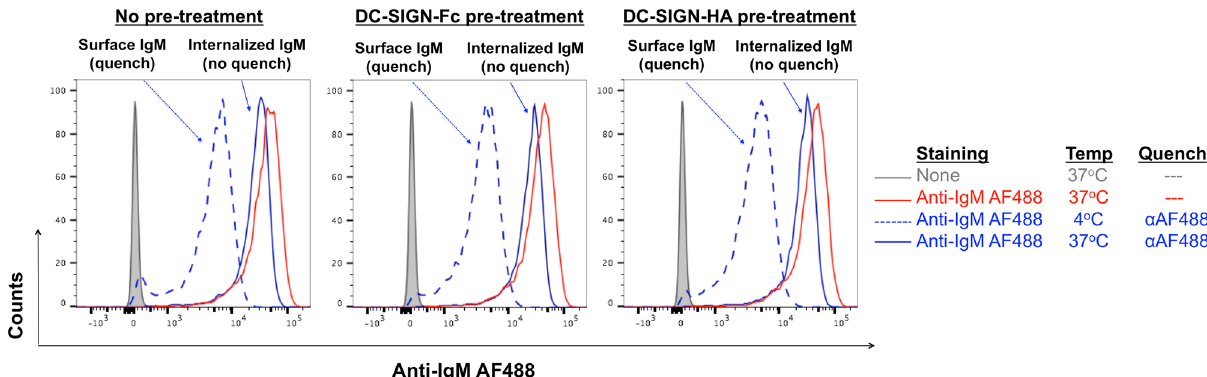
Figure 5. Effect of DC-SIGN pre-exposure on anti-IgM-induced endocytosis. ( a ) WSU-FSCCL cells incubated with AF488-conjugated anti-IgM (5 μg/ml) at 4 or 37 °C or were left untreated for 30 min. Then cells were incubated with anti-AF488 antibody (30 min at 4 °C to quench AF488 remaining on the surface), or left untreated. Graph on the left shows cells with no pre-treatment, whereas graphs in the middle and right show results for cells that were pre-treated for 30 min at 4 °C with DC-SIGN-Fc or DC-SIGN-HA respectively, prior to anti-IgM